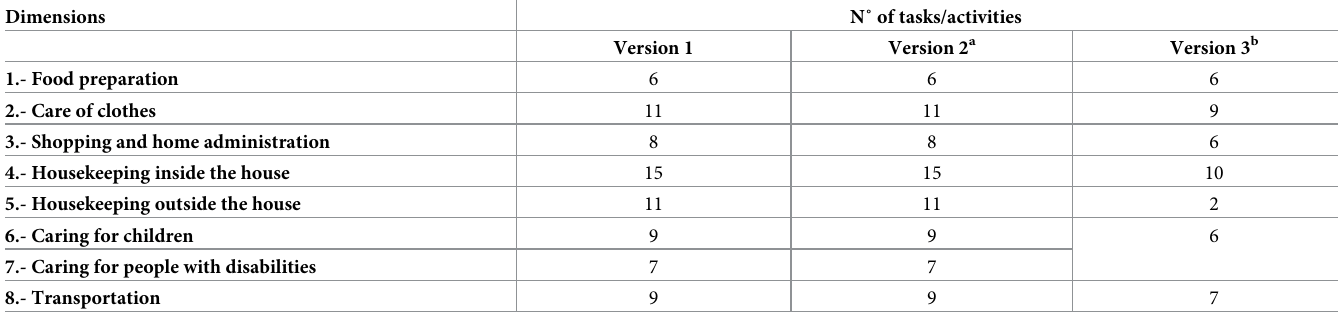
Table 4. HOWL-Q versions ‘structure previous validation